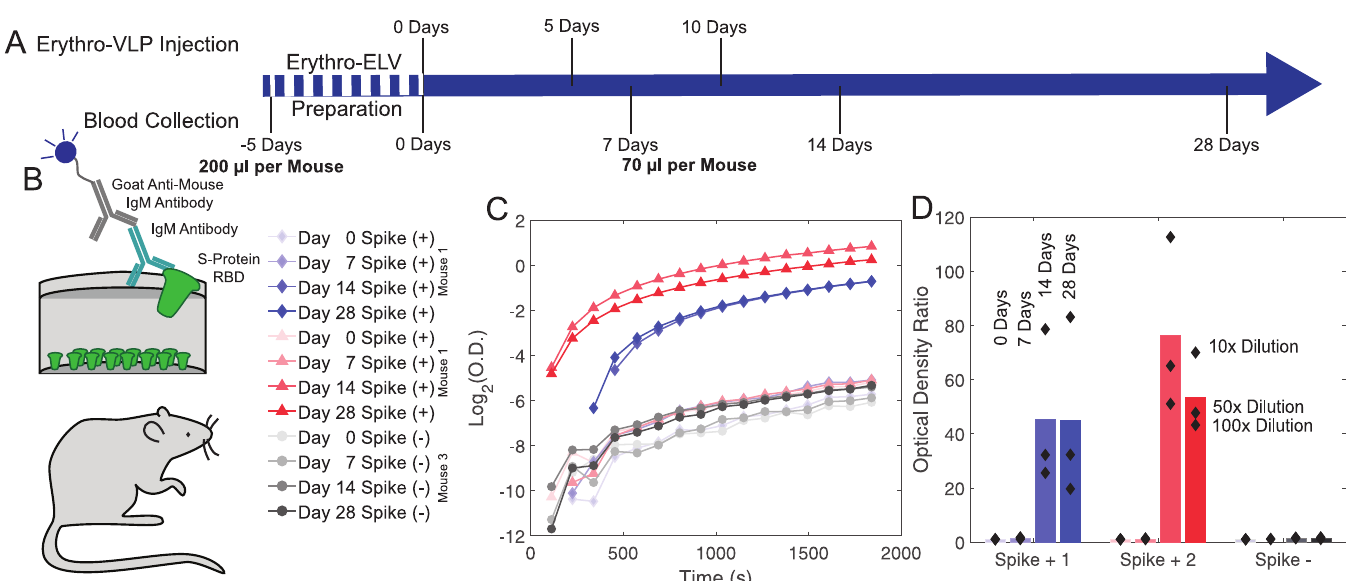
Fig 4. A : Time line of the mouse study. Each mouse received 3 injections of Erythro-VLPs suspended in sterile saline buffer at 0, 5, and 10 days. The liposome concentration in each dose was approximately 30 nM containing 8 μ g of the S-protein. Blood was drawn at 0 (control), 7, and 14 days. Final draw was after 28 days. B : An enzyme-linked immunosorbent assay (ELISA) was used for antibody detection. C : Optical density as function of time for the ELISA essay for all samples. D : Measured optical density ratios. Bars represent the mean optical density ratio averaged over all three dilution runs. Values above 1 ratio are considered positive in the SARS-CoV-2 antibody ELISA. A strong antibody response was observed in both mice after 14 days; no response was observed in the control.